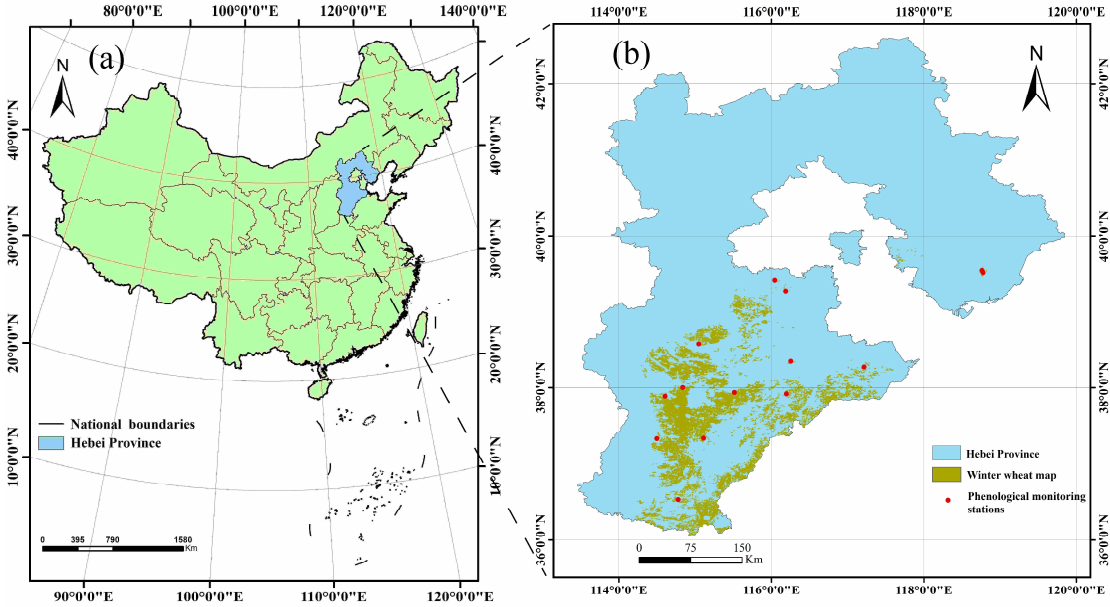
Figure 1. ( a ) The location of the study area. ( b ) The winter wheat map and phenological monitoring stations.